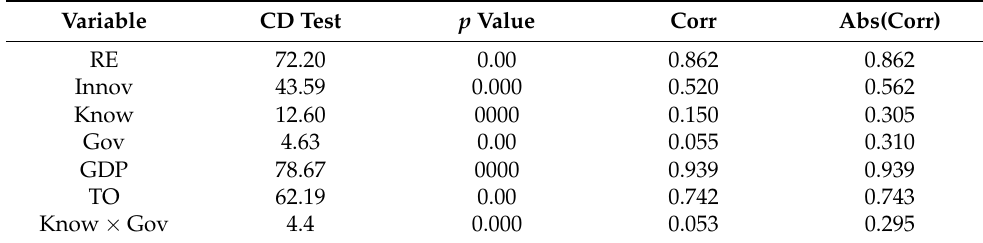
Table 3. The results of Pesaran test for cross-sectional